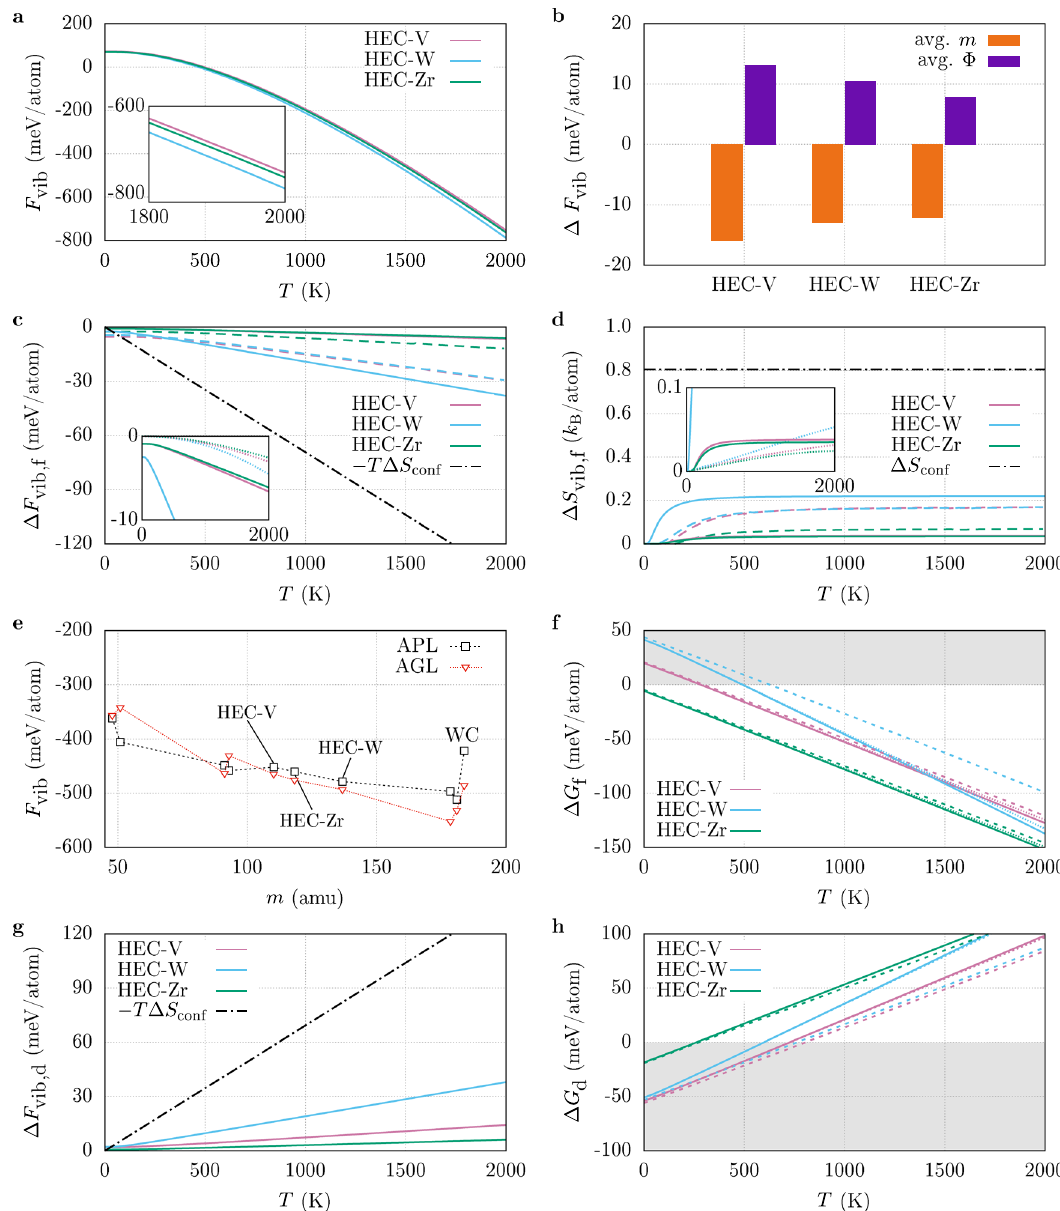
Fig. 4 Stability of high-entropy carbides (HECs). a Temperature-dependent vibrational free energy F vib of HfNbTaTi R ð Þ C (HEC- R ) with T POCC = 2473 K. b Changes in F vib of the HECs at 1500 K when force constant disorder (avg. Φ ) and mass disorder (avg. m ) are removed. A temperature of 1500 K was chosen as entropy changes are constant in this regime (see d ). c Vibrational free energy Δ F vib,f and d entropy changes Δ S vib,f for the formation reaction of the HECs from binary reactants along with con fi gurational entropy contributions Δ S conf . Solid and dashed lines represent values obtained from the Automatic Phonon and GIBBS Libraries (APL and AGL), respectively. Insets: comparison of vibrational and electronic contributions Δ F elec,f / Δ S elec,f (dotted lines). e F vib from APL and AGL as a function of (average) cation mass m at 1500 K. f Gibbs free energy changes Δ G f for the formation reaction of the HECs (solid lines). Δ G f without Δ F vib,f is shown as dashed lines. Shaded areas symbolize energies at which the HECs are unstable. g APL vibrational free energy changes Δ F vib,d for the predicted decomposition reactions of the HECs compared with contributions from S conf . h Gibbs free energy changes Δ G d for the decomposition reaction of the HECs (solid lines). Δ G d without Δ F vib,d is shown as dashed lines. Shaded areas symbolize energies at which the HECs are